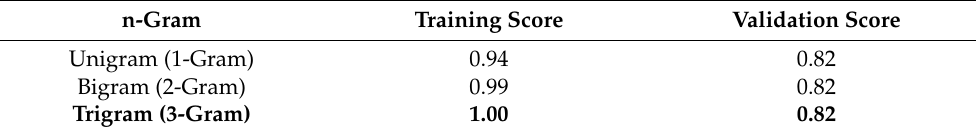
Table 5. Using the SGDClassifier , the data were trained and validated to obtain the best n-Gram value.